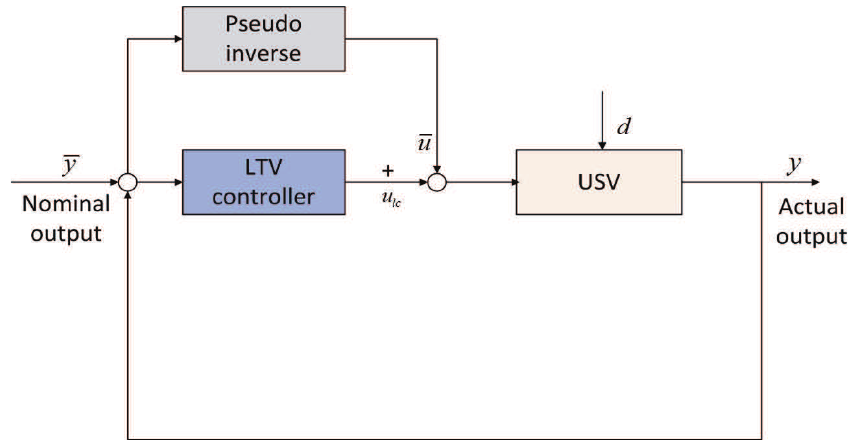
Figure 1. Block diagram of trajectory linearization control (TLC)